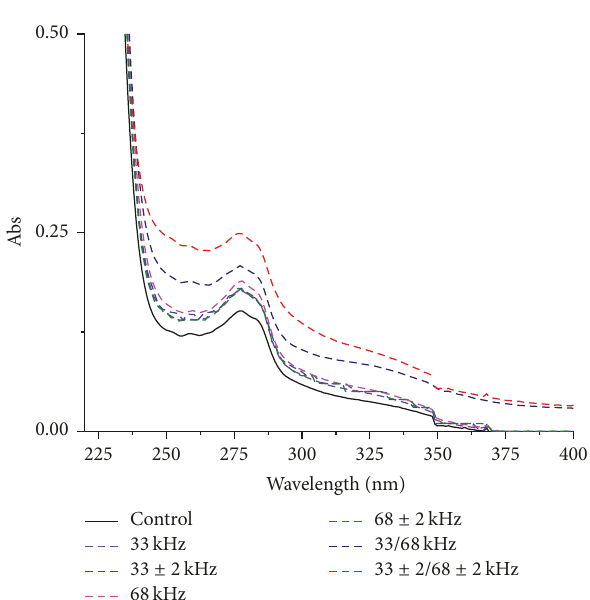
Figure 5: Effects of pretreatment with ultrasound bath with four different working modes and two frequencies on the ultraviolet- visible spectra of zein.